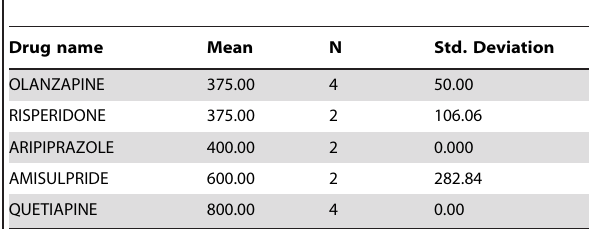
Table 2. All patients were treated with